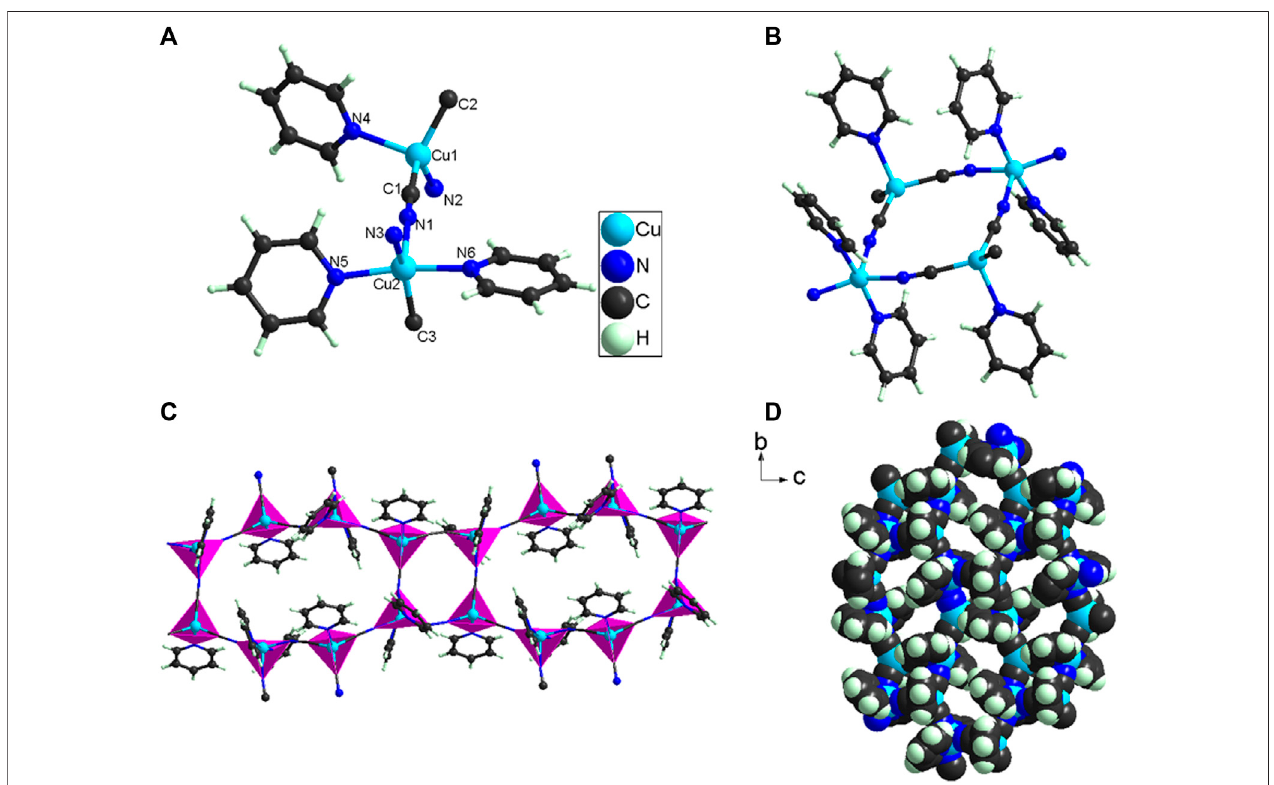
FIGURE 2 | (A) The smallest structural unit of 1 ; (B – C) The 2D structure formed by -CN bridged Cu(I)/Cu( II); (D) Hole distribution in 2D structure of 1 .